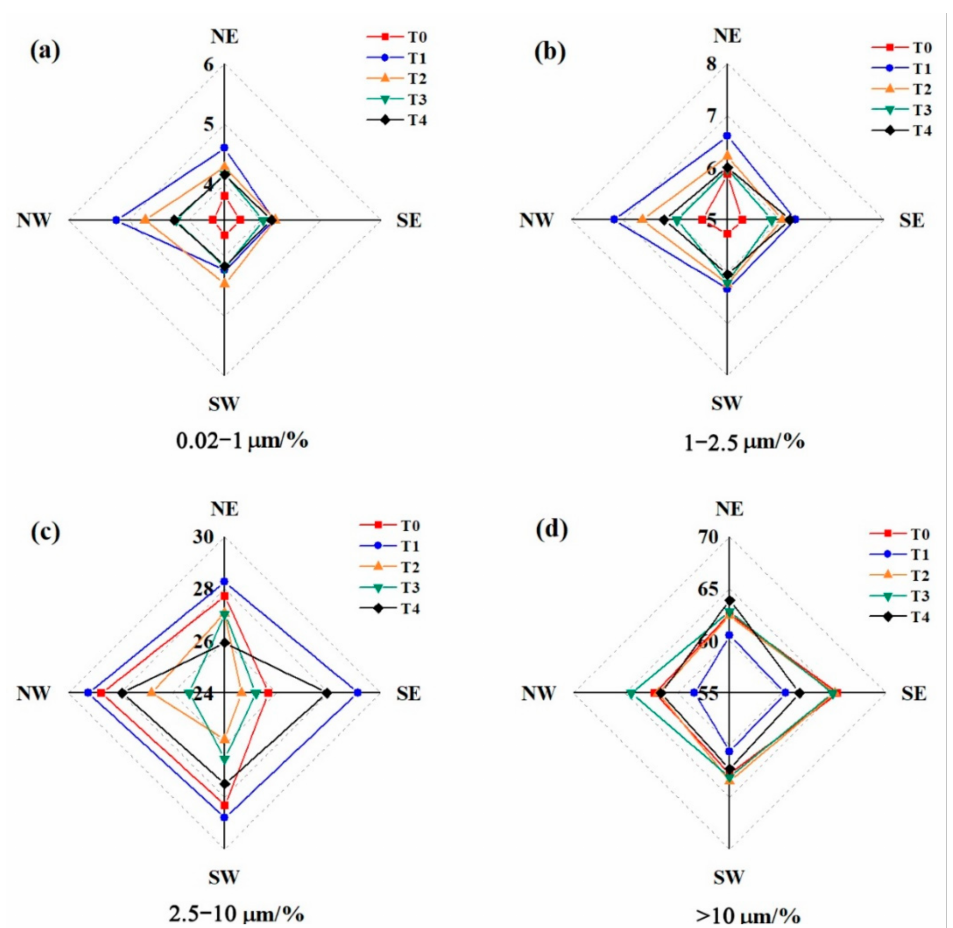
Figure 4. Directional percentages of ( a ) 0.02–1 µ m, ( b ) 1–2.5 µ m, ( c ) 2.5–10 µ m, and ( d ) >10 µ m particles deposited on needles at sites